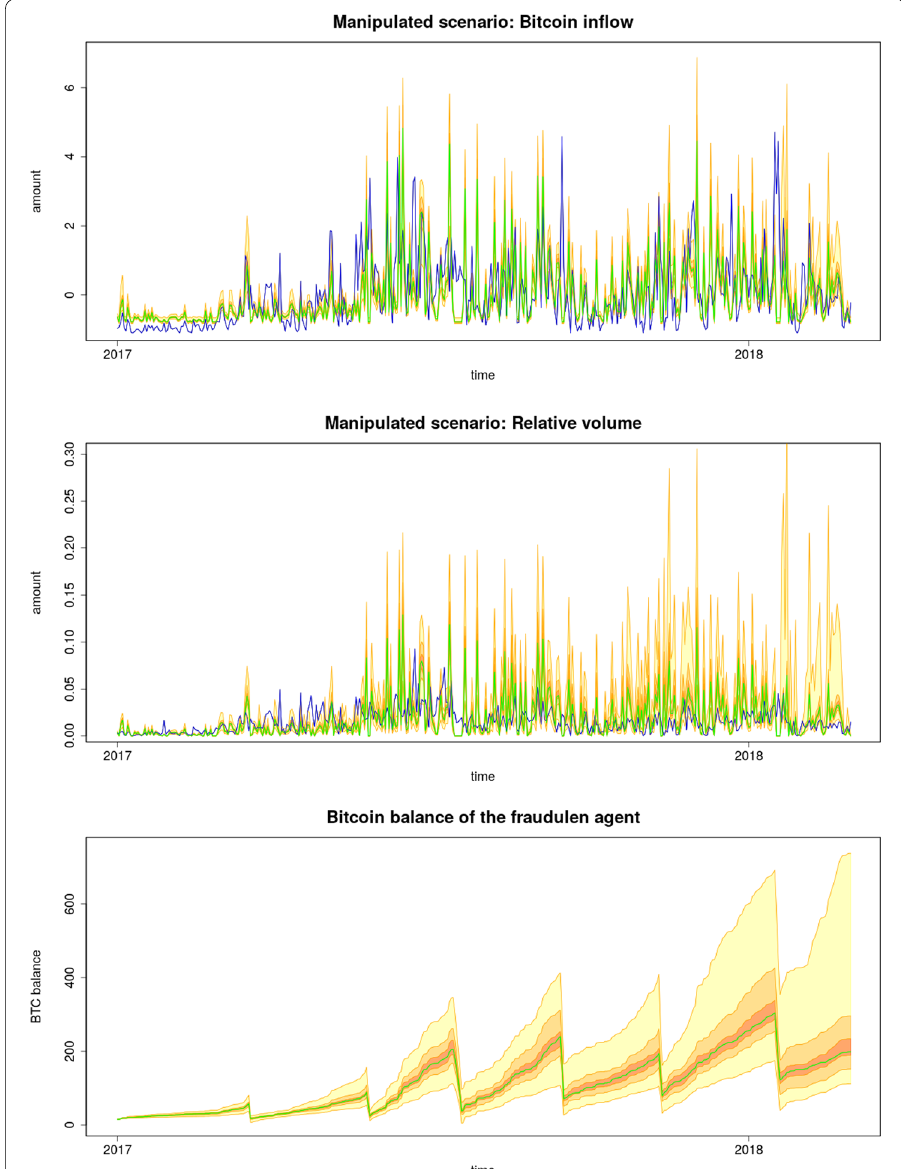
Fig. 6 Time series detailing the behavior of the fraudulent agent with respect to empirical data (blue); compared to the simulated median (green) with 20th, 50th and 95th prediction